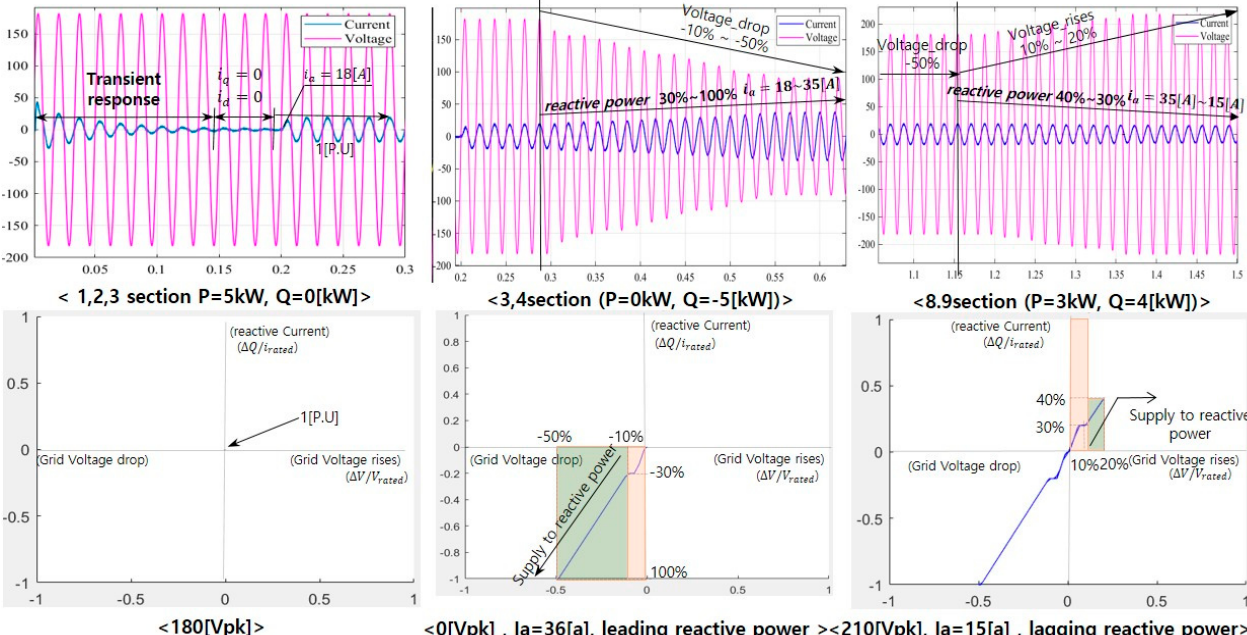
Figure 18. Results of simulation experiment for each variable section of grid voltage and current.